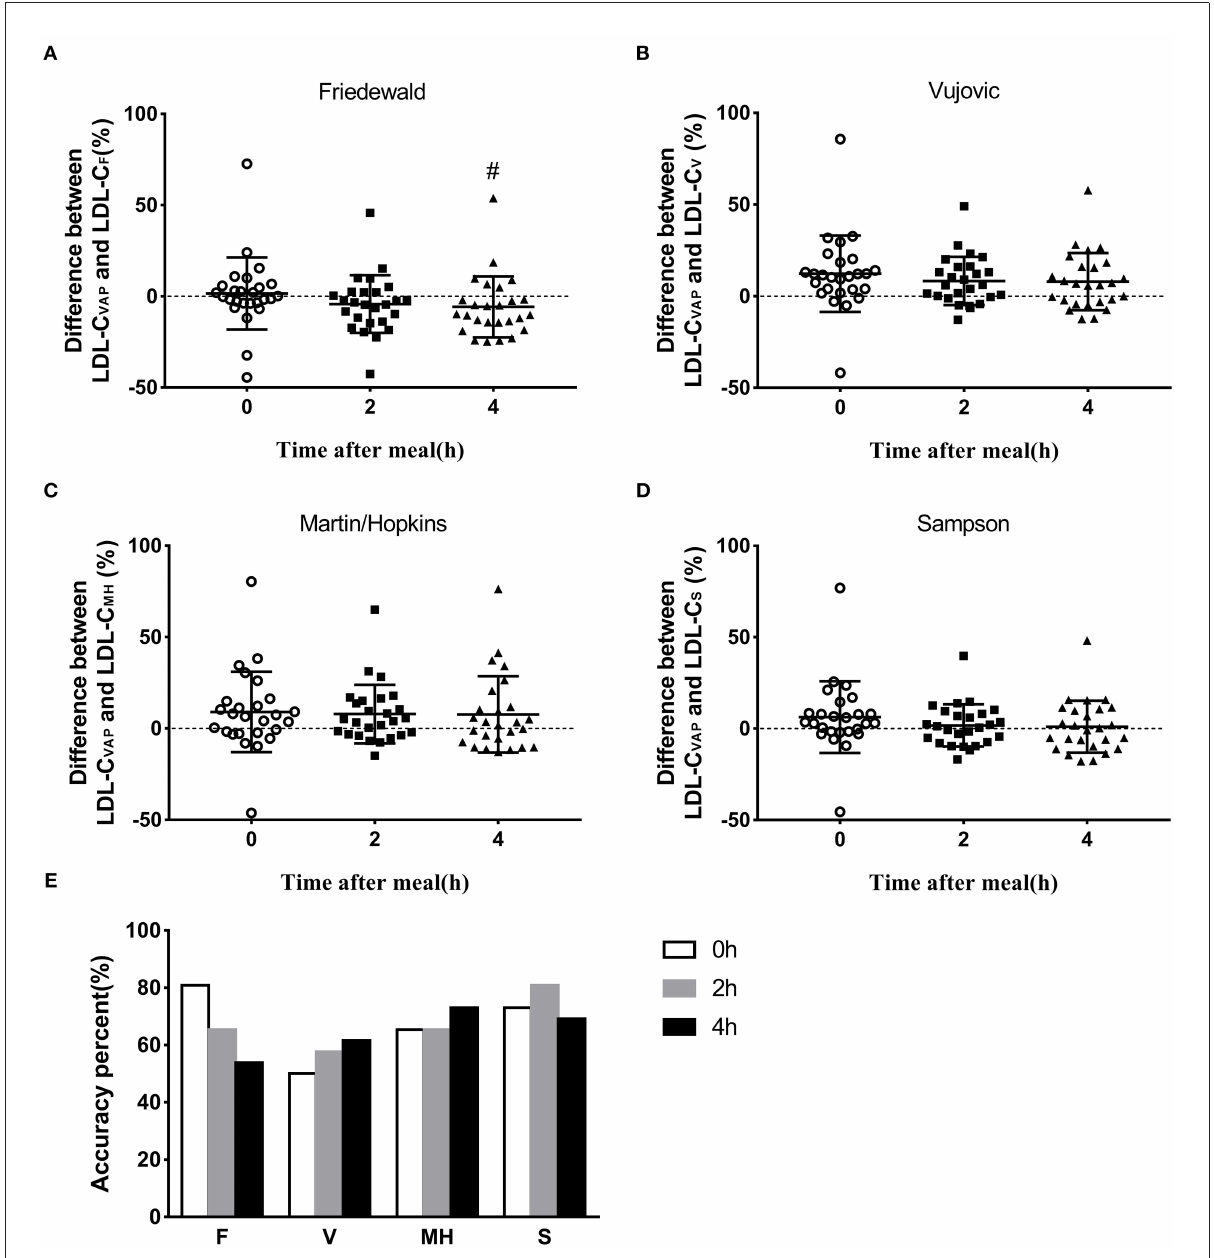
FIGURE3 Accuracy of estimated LDL-C via different formulas. (A–D) Difference between LDL-C VAP and LDL-C formula at fasting and postprandial states. (E) Accuracy percent (total error ± 12%) of calculated value via four formulas at fasting and postprandial states. # P < 0.05 when compared with fasting